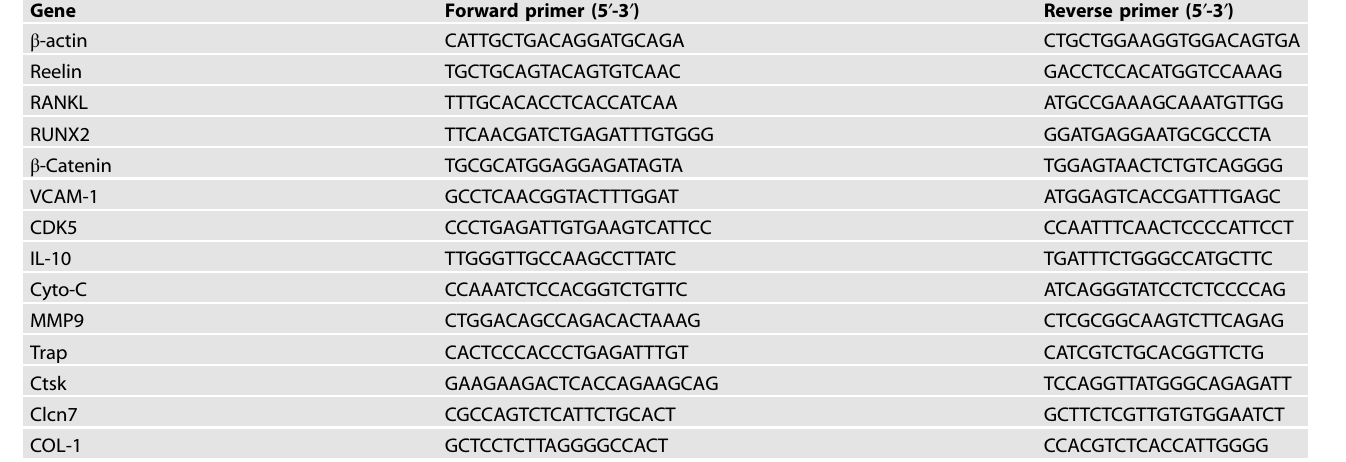
Table 2. Primers used in qRT-PCR